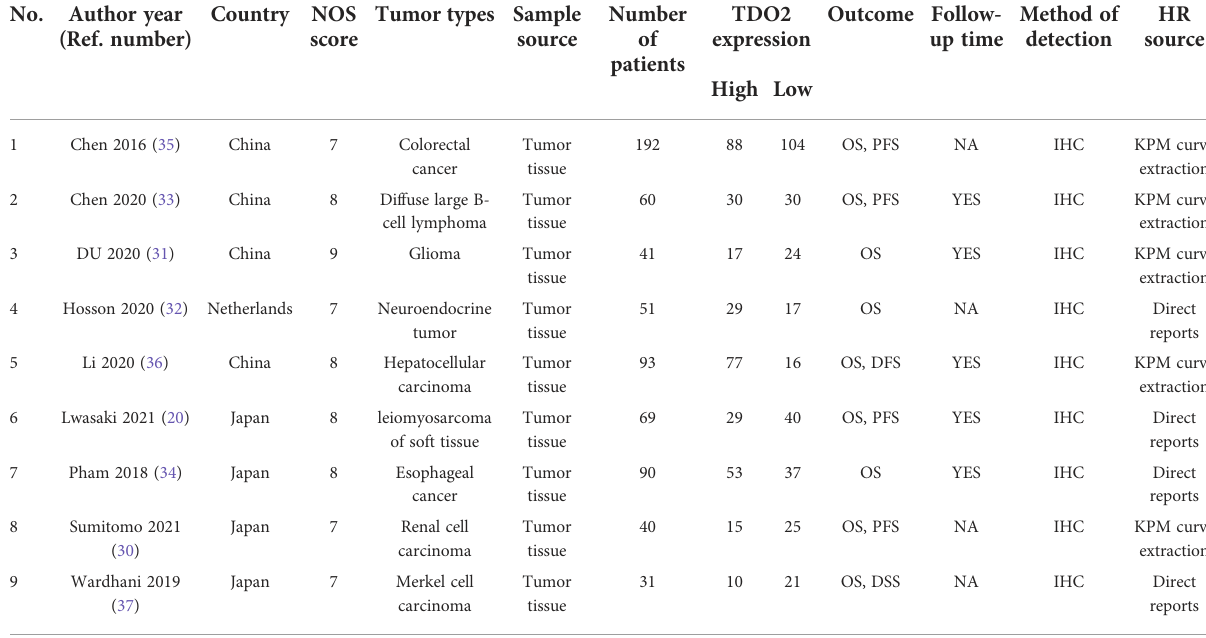
TABLE 1 Main characteristics of the eligible studies for the meta-analysis.